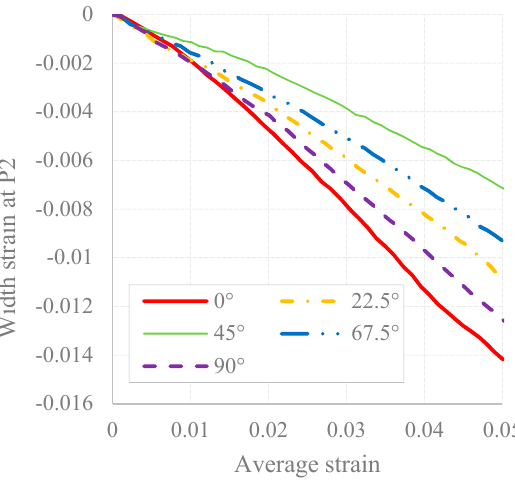
Figure 8. Nominal stress corresponding to the average strain.